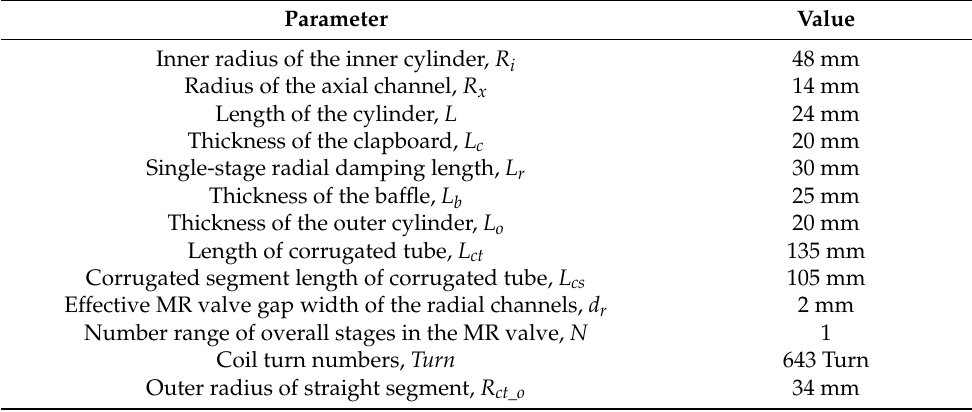
Figure 1. Schematic of an HVLP MRF-based MREA with radial flow mode: ( a ) two-dimensional and ( b ) three-dimensional models. HVLP: high-viscosity linear polysiloxane; MRF: magnetorheological fluid; MREA: magnetorheological energy absorber. Table 1. Dimensions of HVLP MRF-based MREA with radial flow mode. Table 1. Dimensions of HVLP MRF-based MREA with radial flow mode.